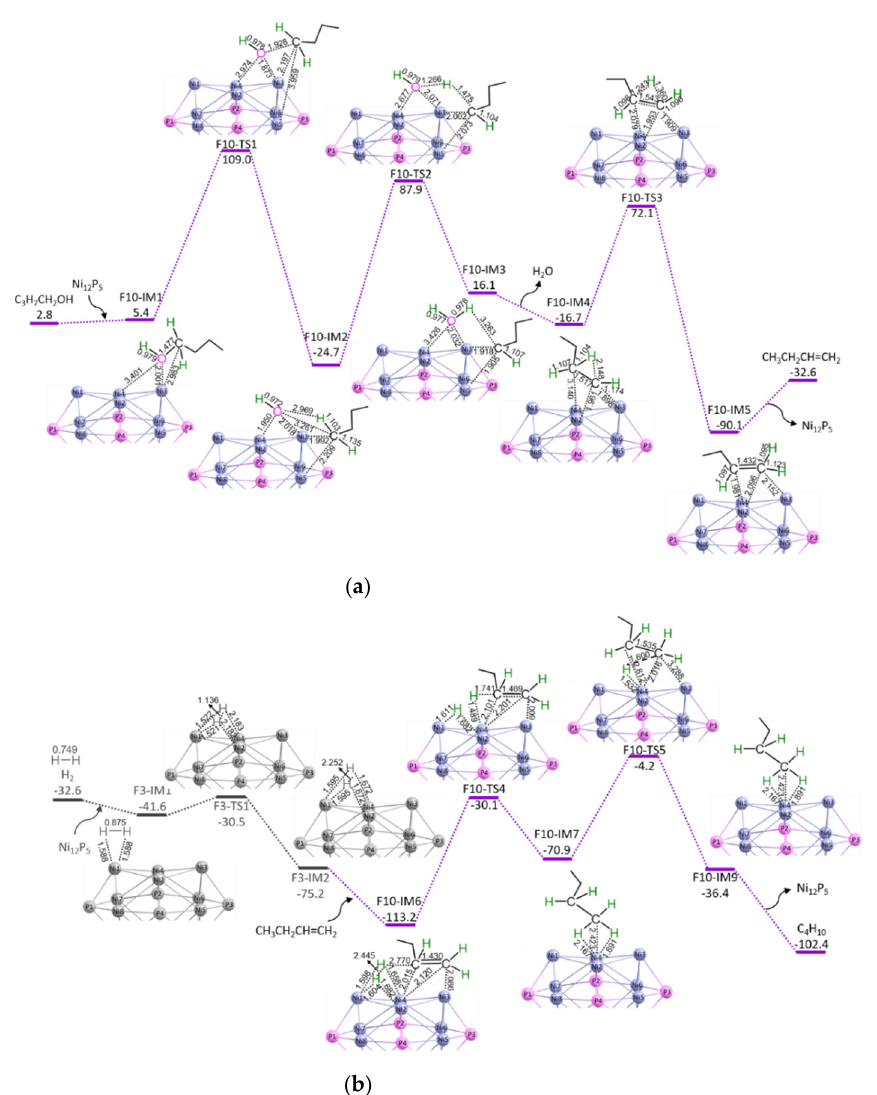
Figure 10. The potential energy curves with the relative Gibbs free energy ( G r , kJ mol − 1 ) and the geometric structures with bond lengths (Å) reaction stages S10a ( a ) and S10b ( b ) over Ni 12 P 5 cluster at GGA − PBE/DSPP, DNP level. For brevity, some hydrogen atoms are hidden.